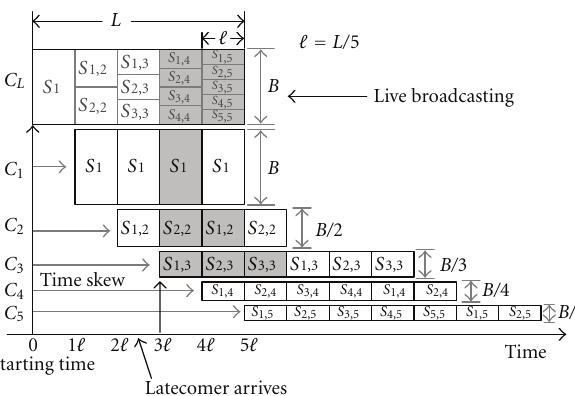
Figure 4: Live harmonic broadcasting scheme.